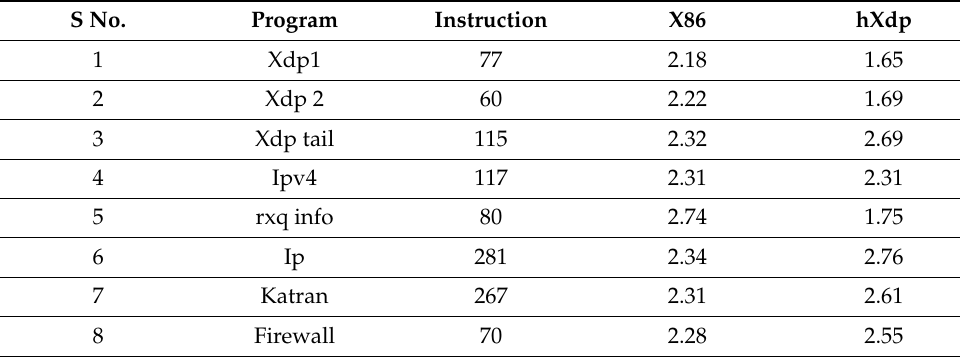
Figure 7. Very long instruction word inputs varying with no. of execution lanes. Table 4. Instruction per cycle and IPC.